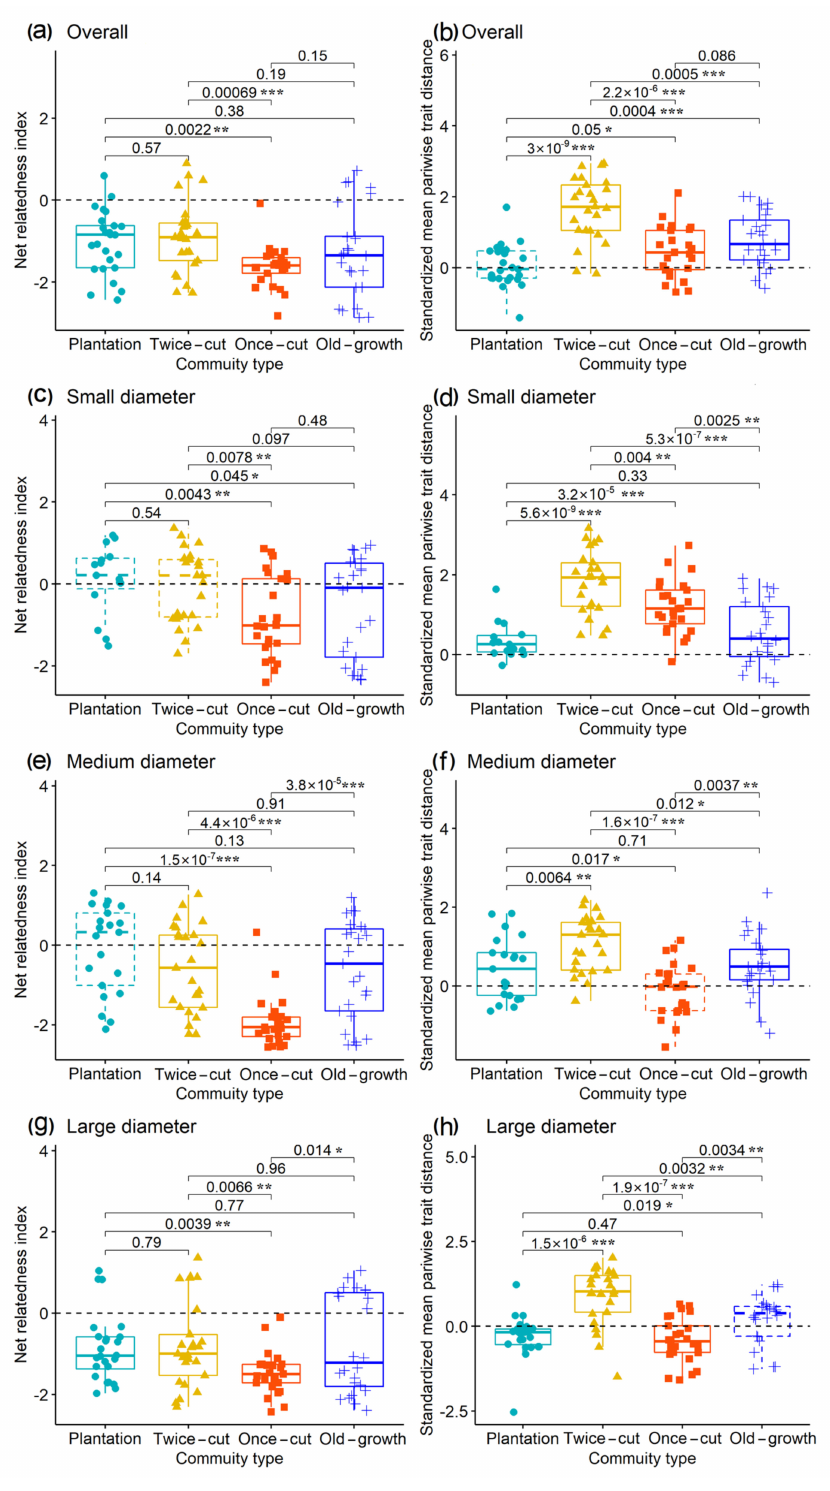
Figure 4. Phylogenetic and functional structure of woody plants in the four disturbance communities. Left, net relatedness index ( NRI ) of overall ( a ), small ( c ), medium ( e ), and large ( g ) diameter classes. Right, standardization mean pairwise distance ( S.E.S PW ) of overall ( b ), small ( d ), medium ( f ), and large ( h ) diameter classes. The black dashed lines at 0 indicate no turnover. Bold box lines represent means that are significantly different from 0, while dashed box lines represent non-significance, using t − tests. Lines joining boxes show the results of Wilcoxon tests between disturbance regimes ( p ≤ 0.05 level of significance). “*”, “**”, and “***” represent p < 0.05, p < 0.01, and p < 0.001,